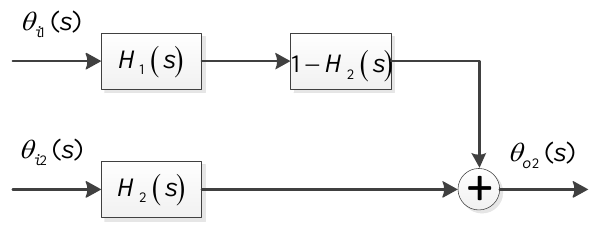
Figure 3. Equivalent structure of the slave tracking